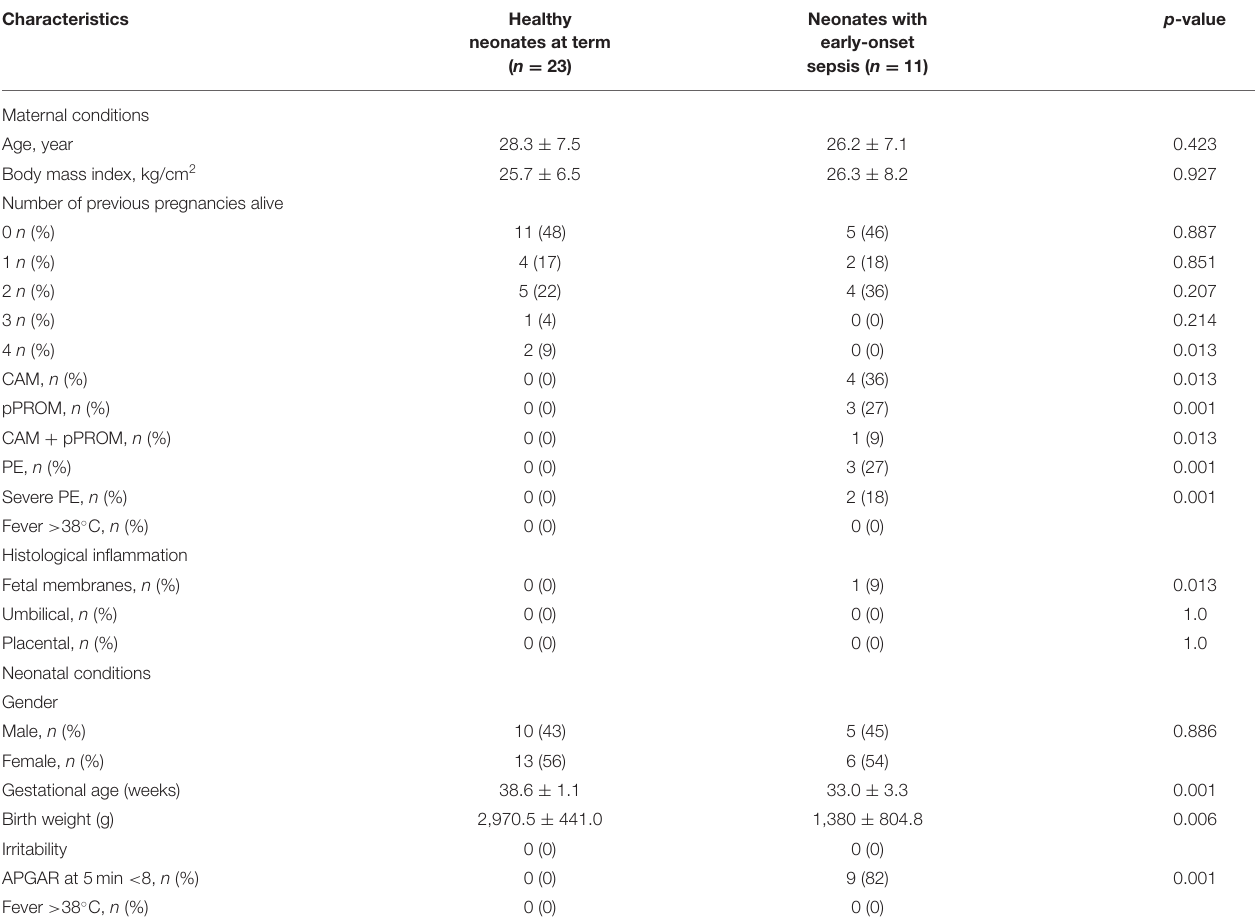
TABLE 1 | Demographic and clinical characteristics of maternal and neonatal patients.